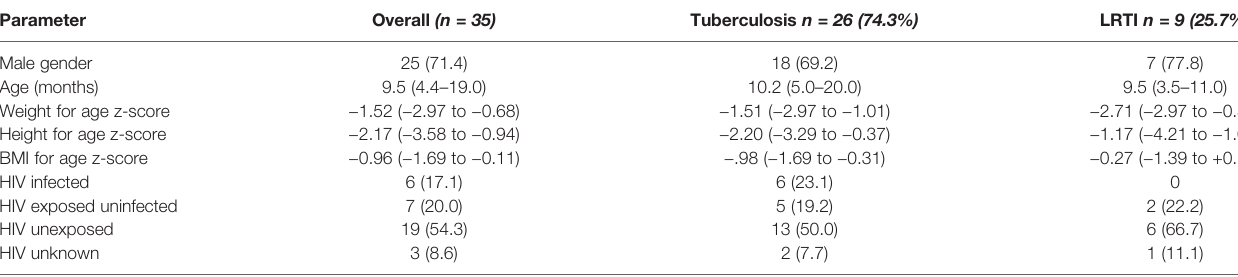
TABLE 1 | Demographic characteristics of young children diagnosed with TB or LRTI.